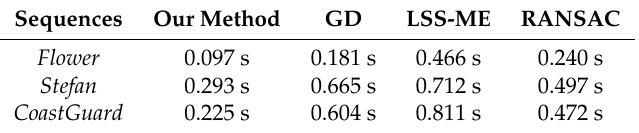
Table 1. Running time tests for GME approaches. (Platform: OpenCV 3.1, Core-i7 CPU 2.8GHZ × 4).